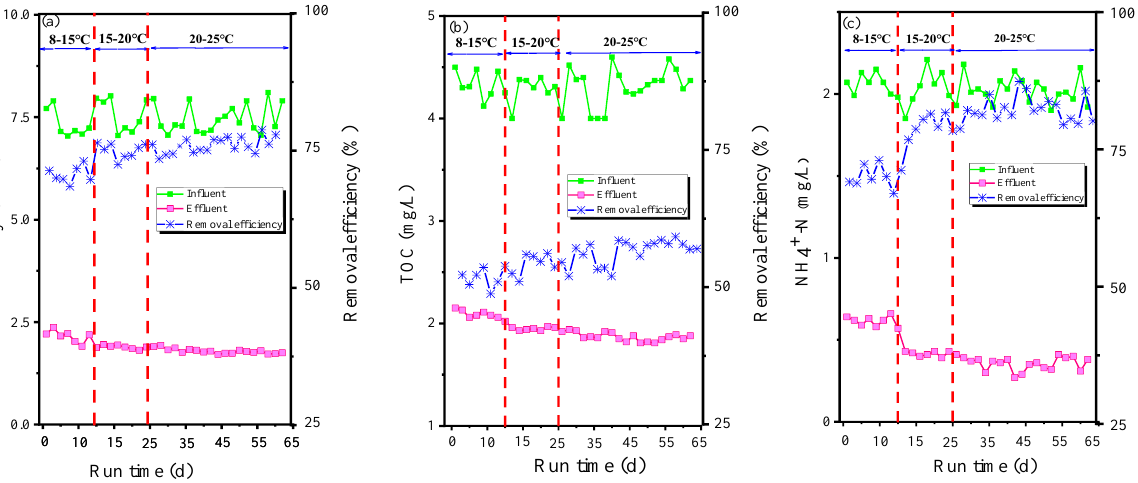
Figure 2. Effects of operating time on the removal of turbidity ( a ), TOC ( b ), and NH + ( c ) in treating organic and NH + -N polluted water with the modified settling tank (HRT = 2.0 h, OLR = 0.35 g/(m 2 · d), and disc rotating speed = 3.0 r/min).